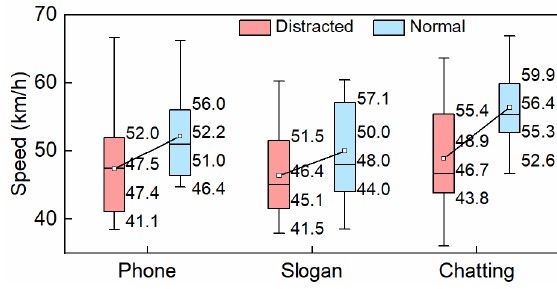
Figure 8. Vehicle speed.